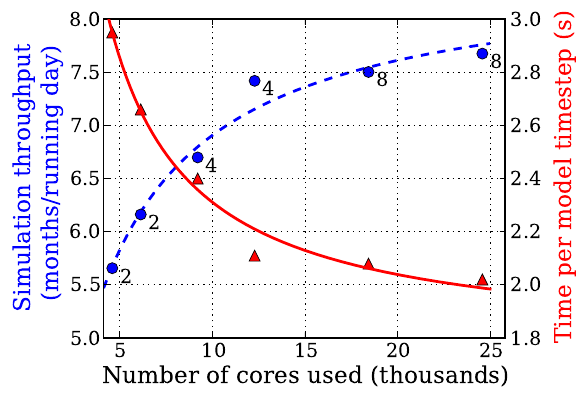
Figure 5. Simulation speed as a function of processor count. Red triangles show time per model time step, blue circles show a calibrated estimation of model throughput. The annotations show the number of OpenMP threads used and lines show least-squares fits to Amdahl’s law.